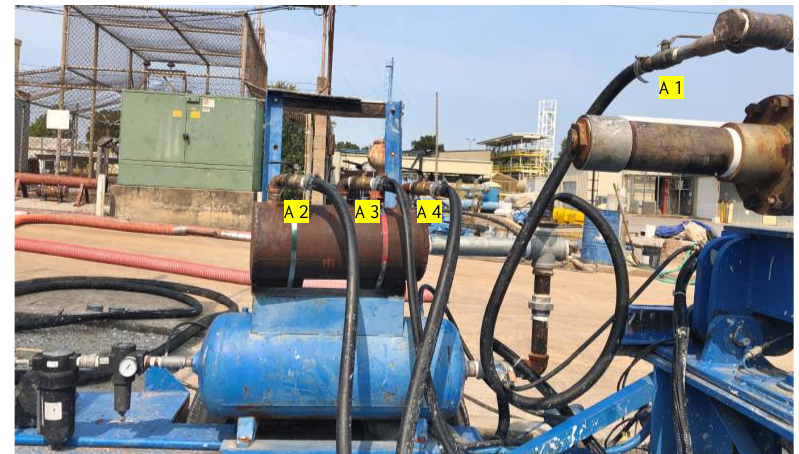
Figure 2. Buffer accumulator and air valve. (A1: release the air under static condition; A2, A3, and A4: release the air under countercurrent flow condition). A 75 hp centrifugal mud pump (maximum capacity of 650 gpm) was used to supply water and low-rheology fluids, which were injected from the top of the flow loop. Figures 3a,b present the pump connection (inlet) and mud return (outlet), respectively. Fluids were pumped into the riser pipe (Figure 3a) to the top of the text section to create downward flow. At the bottom of the test section, a gate valve (Figure 3b) was used to control pressure in the system. Maintaining adequately high pressures was necessary to prevent the formation of vacuum bubble in the test apparatus—especially at inclinations near vertical.